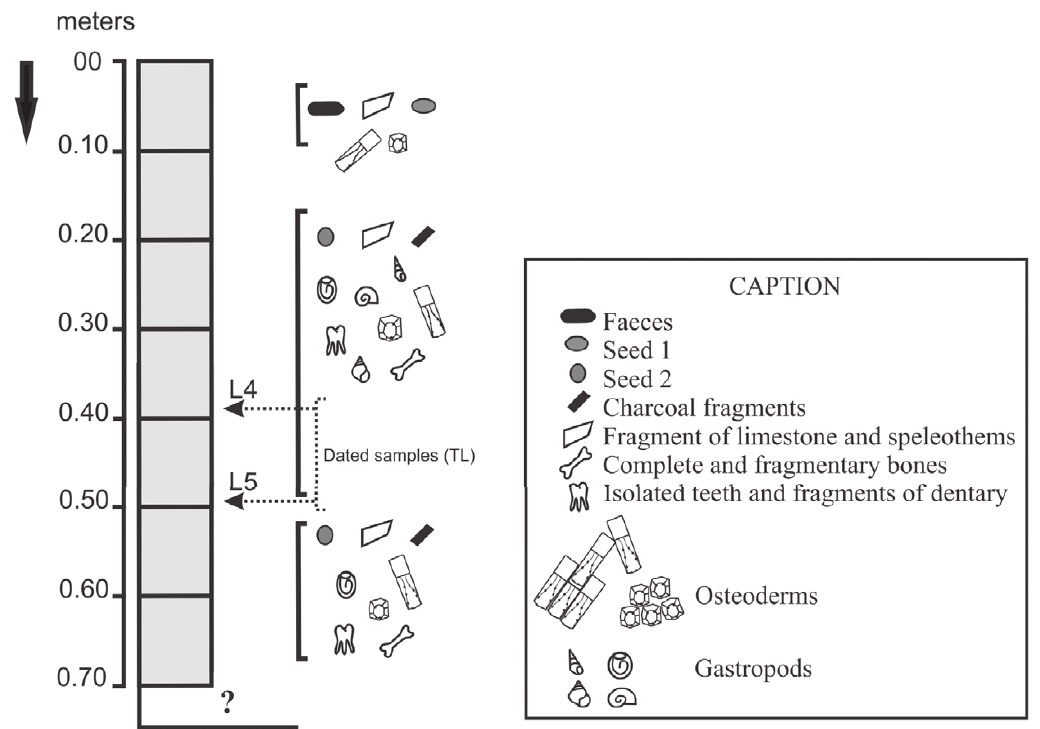
Figure 2 - Stratigraphic section of “Sala da Entrada” Urso Fóssil Cave, showing the L4 and L5 levels from where dated samples were obtained. Urso Fóssil Cave. Modifi ed from Oliveira et al. (2011b).